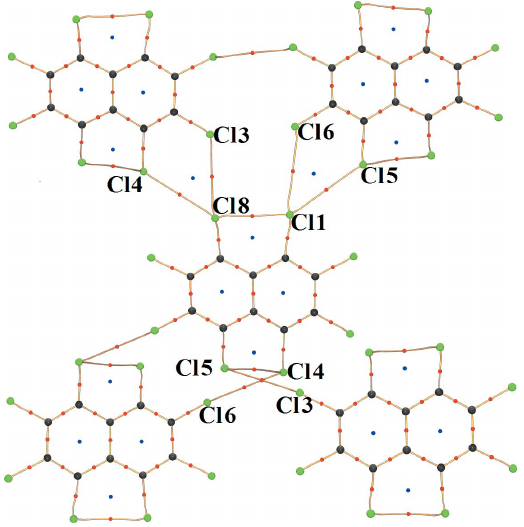
Figure 8 Molecular graph depicting the various intermolecular Cl (cid:2)(cid:2)(cid:2) Cl interac- tions involving ( a ) peri interaction pair Cl1 and Cl8; ( b ) peri interaction pair Cl4 and Cl5.